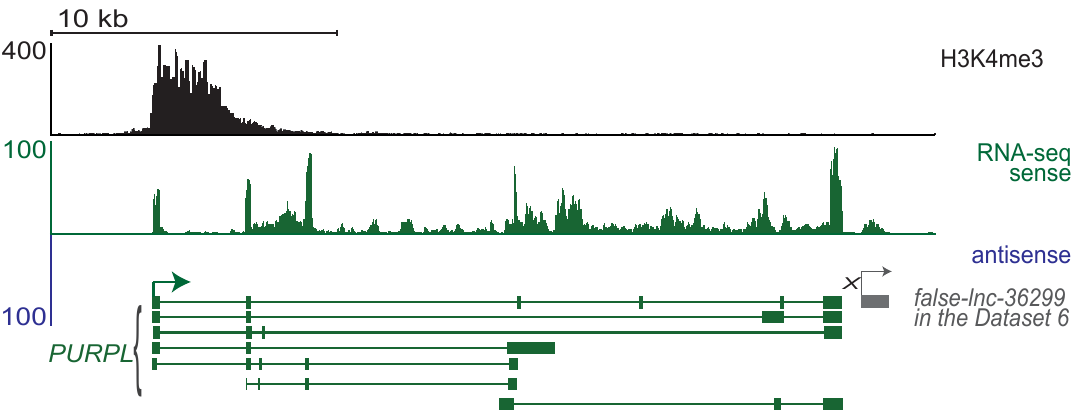
Figure 1. Identification of true and false lncRNAs. ( A ) Flowchart of the standard computational